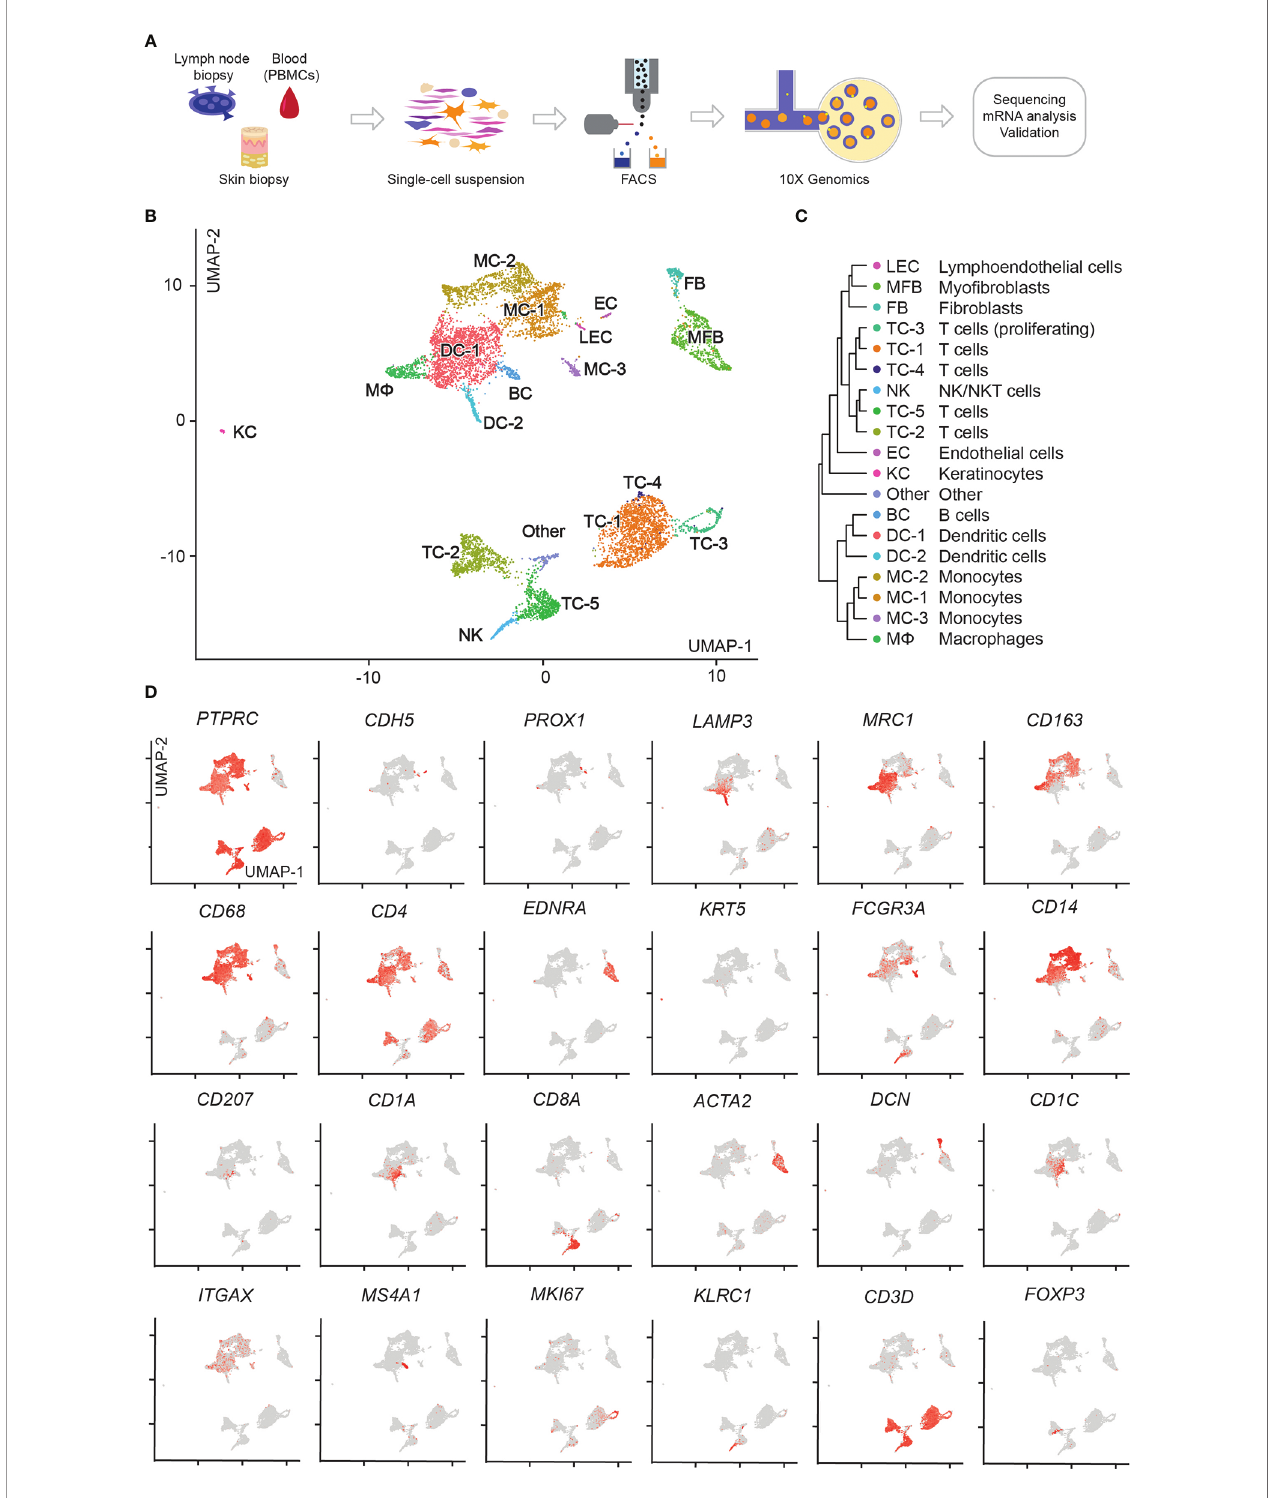
FIGURE 2 | scRNA-seq work fl ow and map of isolated cells from lymph node, blood, and skin. (A) Outline of steps for single cell pro fi ling of trancriptomes from different tissues. (B) UMAP of 9,028 cells integrated from lymph node (1,215), blood (3,301), and skin (4,512) samples according to similarity of their transcriptome, resulting in 19 different color-coded clusters. (C) Unsupervised hierarchical clustering showing relatedness of cell clusters (average gene signatures; correlation distance metric and average linkage). (D) Combined feature plots of all samples showing expression distribution for canonical markers. Intensity of normalized expression for each cell is color-coded (red) and overlaid onto UMAP